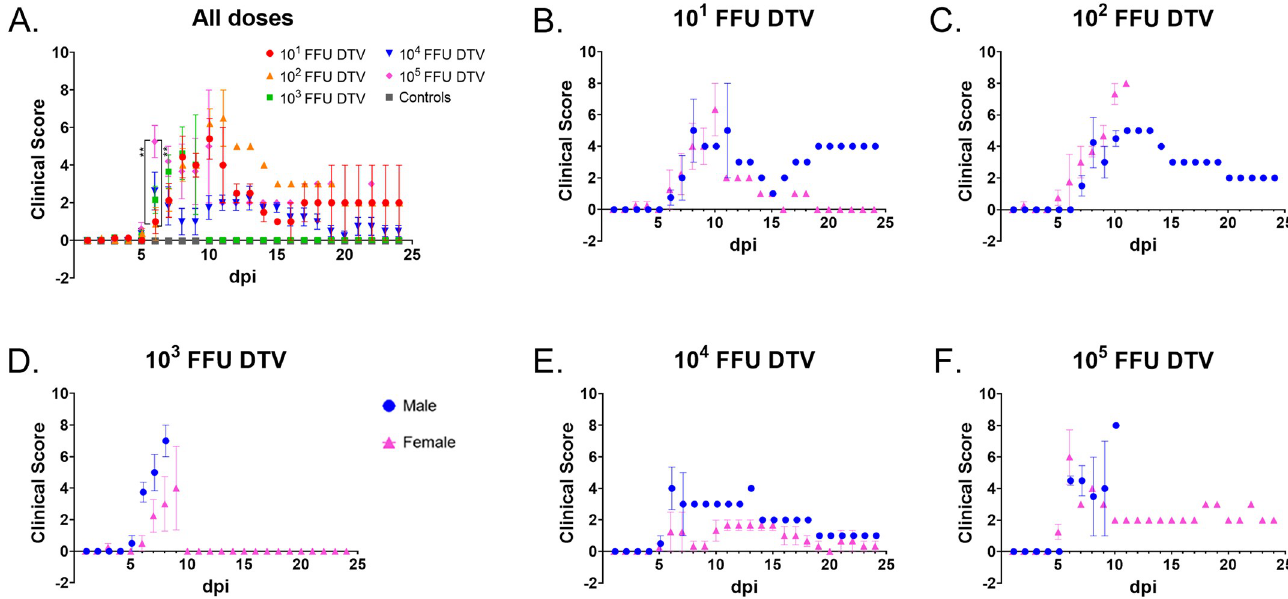
Fig 3. Clinical disease score for DTV-infected mice. Clinical signs of disease were assessed daily, and each mouse was assigned a cumulative clinical score based on the scoring system shown in S1 Table. A ) Mean clinical disease scores for each infection dose cohort (n = 8) are plotted. B–F ) Daily mean clinical disease scores are plotted for male (n = 4) and female (n = 4) mice inoculated with B ) 10 1 FFU DTV, C ) 10 2 FFU DTV, D ) 10 3 FFU DTV, E ) 10 4 FFU DTV, or F ) 10 5 FFU DTV. Error bars represent